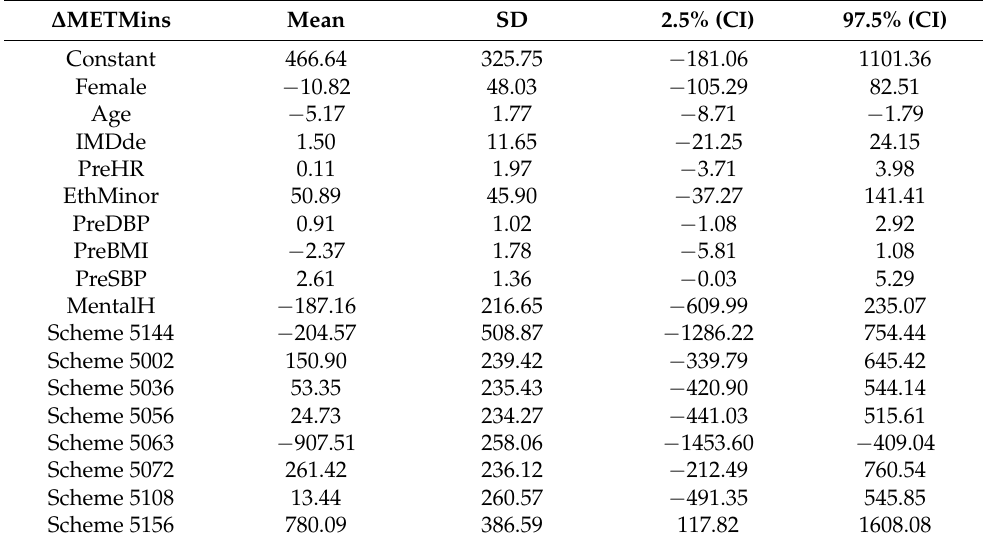
Table 2. Outcomes of scheme completion (DV = change in